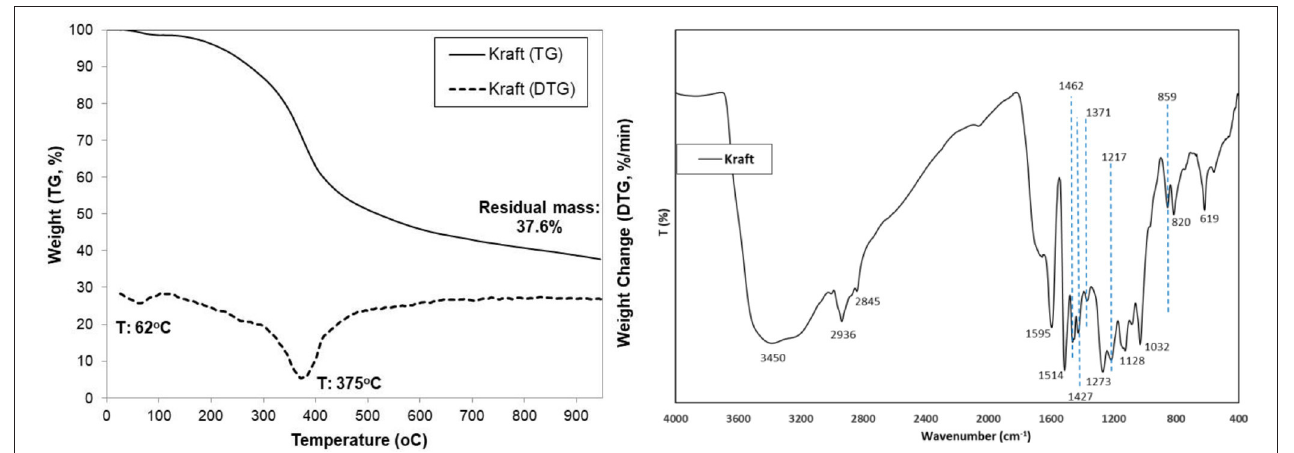
FIGURE 1 | TGA and DTG curves ( left ) and FT-IR spectrum ( right ) of kraft lignin.